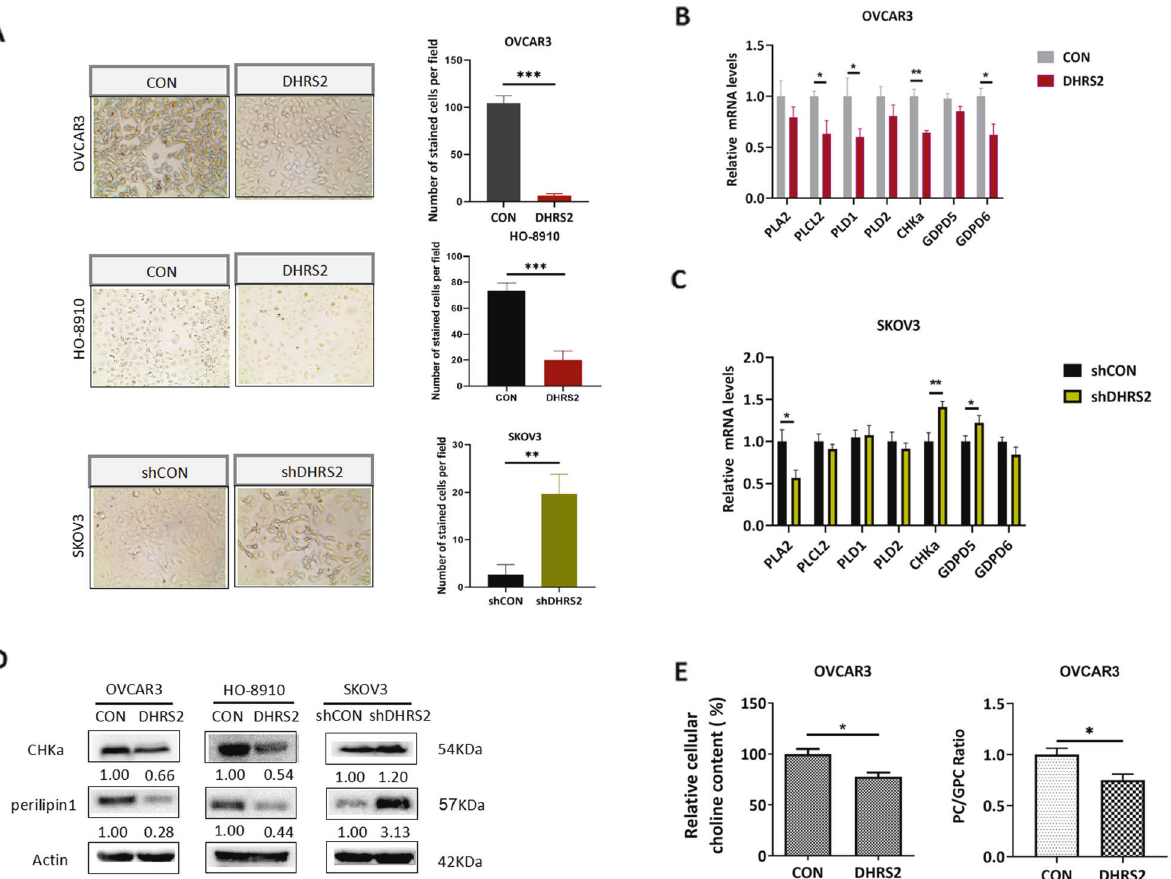
Fig. 3 CHK α downregulation is involved in the interruption of choline metabolism by DHRS2. A Oil red O staining indicating the content of LD in OVCAR3-CON, OVCAR3-DHRS2, HO-8910-CON, HO-8910-DHRS2, SKOV3-shCON, and SKOV3-shDHRS2 cells. The mRNA levels of PLA2, PLCL2, PLD1/2, CHK α , and GDPD5/6 in B OVCAR3-CON, OVCAR3-DHRS2 and C SKOV3-shCON and SKOV3-shDHRS2 cells detected by RT-qPCR. D The protein expression levels of CHK α and perilipin1 in OVCAR3-CON, OVCAR3-DHRS2, HO-8910-CON, HO-8910-DHRS2, SKOV3-shCON, and SKOV3-shDHRS2 cells. β -actin was used as a loading control. E The cellular choline content and PC/GPC ratio in OVCAR3-CON and OVCAR3- DHRS2 cells. Data are shown as mean values ± S.D. of independent, triplicate experiments. The asterisks (*,**,***) indicate signi fi cant differences ( p < 0.05, p < 0.01, p < 0.001,